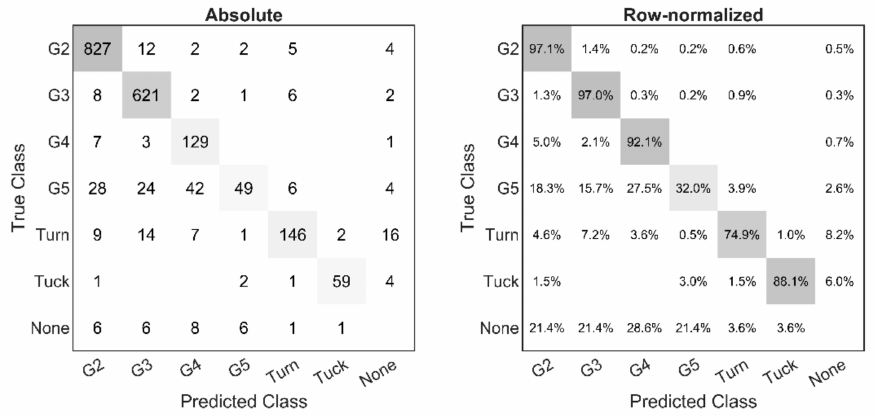
Figure 7. Left: Confusion matrix showing the automated classification algorithm’s performance during the roller skiing test race. Rows represent manual classification from video, columns represent the automated classification method. Diagonal entries show the number of correctly classified cycles while off-diagonal entries are instances where the predicted and true class differ. The rightmost column and bottom row represent cycles not detected by the automated algorithm and falsely detected cycles (i.e., not apparent in the video), respectively. Right: Same information as in left matrix but normalized to the number of true cycles detected in each sub-technique (i.e., row sum). Hence, diagonal entries show the method’s